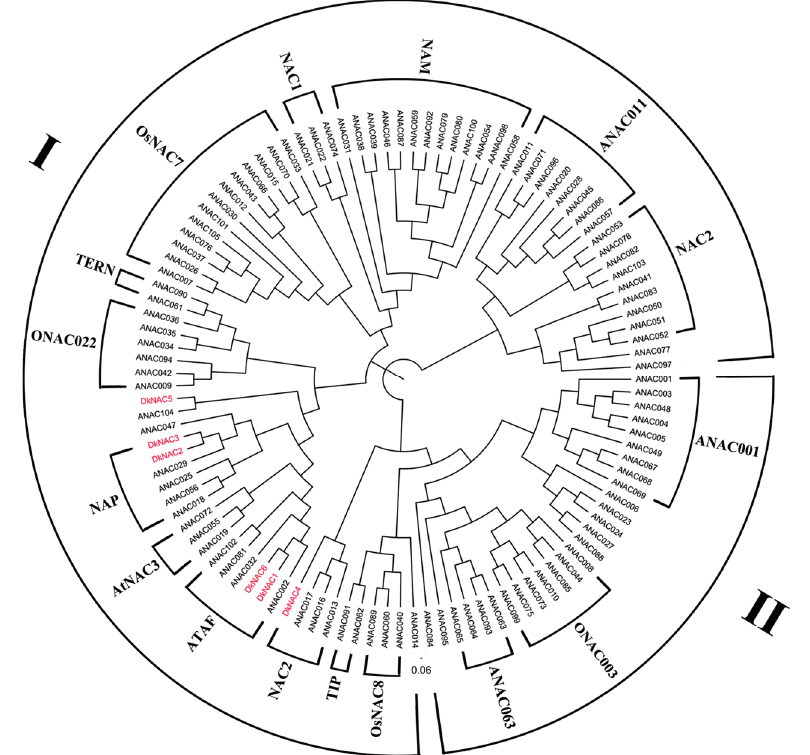
Figure 5. Phylogenetic tree of NAC genes. Persimmon DkNAC genes are highlighted in